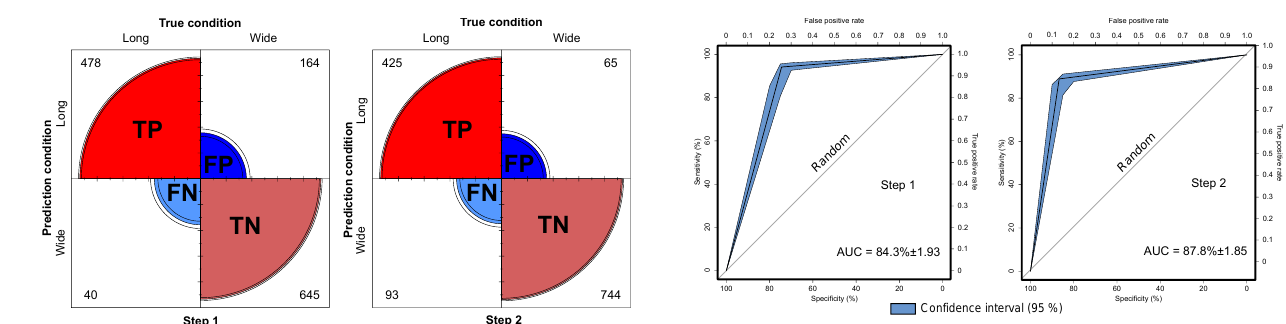
Figure 9. Four folded plots of the confusion matrices for the two steps of the algorithm (TP denotes true positive, TN true negative, FP false positive and FN false negative).